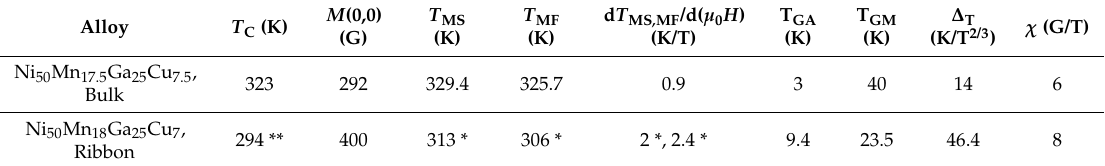
Table A1. Parameters used for